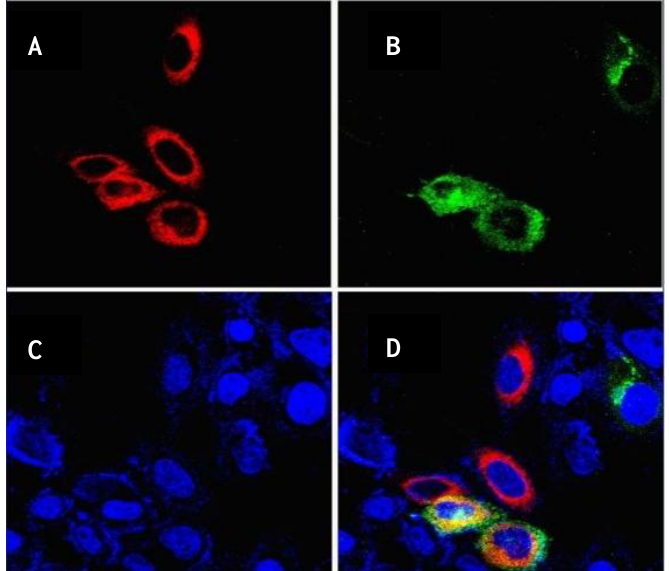
Figure 4. Co-localization of GLT8D2 and calreticulin in HepG2 cells. ( A ) Calreticulin with red fluorescence; ( B ) GLT8D2 with green fluorescence; ( C ) Nuclear with blue fluorescence; ( D ) Calreticulin and GLT8D2 merge with yellow fluorescence. B